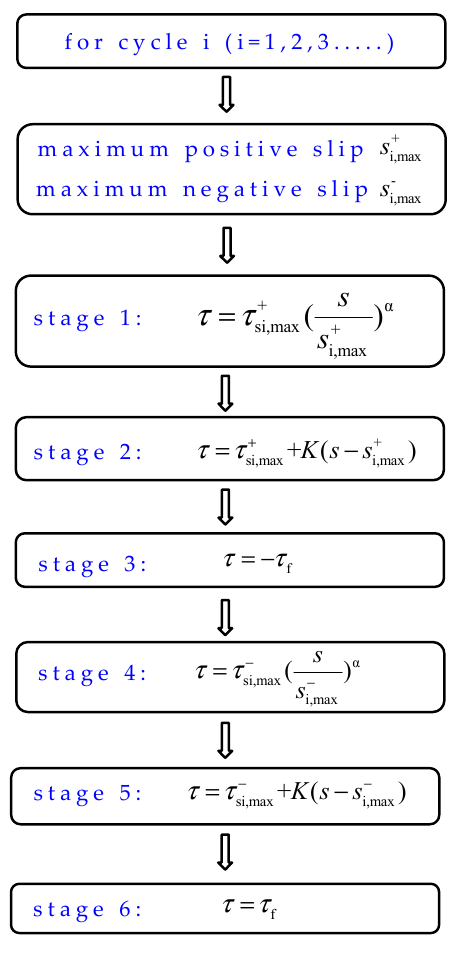
Figure 13. Calculation process.